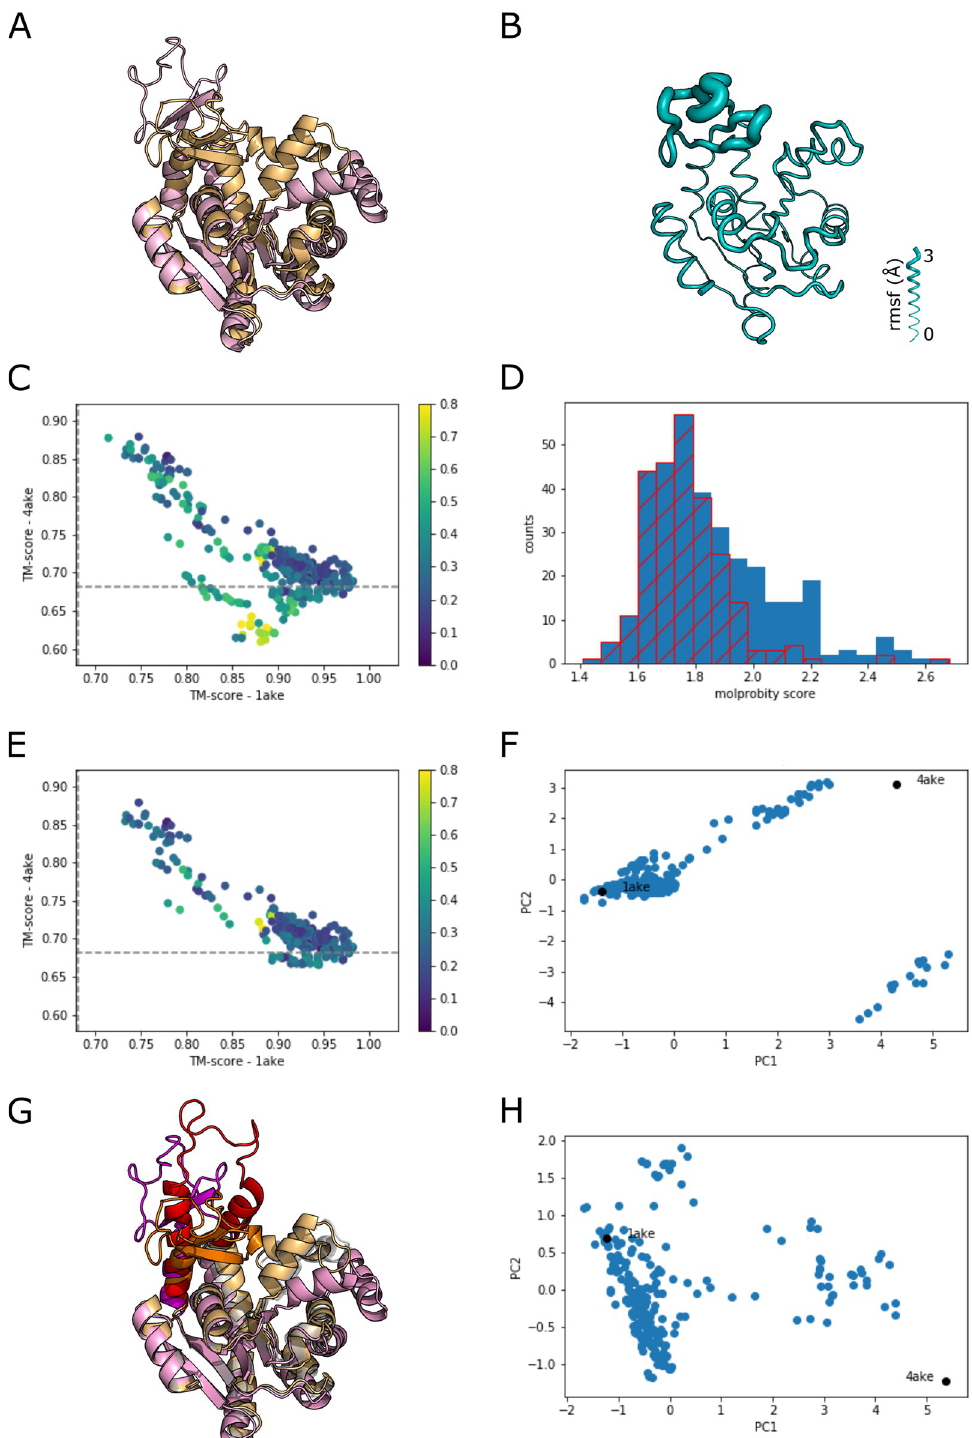
Fig 2. Sampling conformational flexibility of Adenylate Kinase (AK). A) Crystal structures of Adenylate Kinase aligned on residues 1–25: closed, 1ake (lightorange) and open, 4ake (lightpink). B) AK model with the thickness of the chain based on the rmsf for the 15 AF2 models from the unmodified MSA. C) TM score plot comparing all AF2 models to the two crystal structures. The dashed line is the TM score between the two experimental structures. The color scale is based on the relative molprobity score, (MP–MPmin) / MPmin. D) Histogram of molprobity scores. In blue are all of the